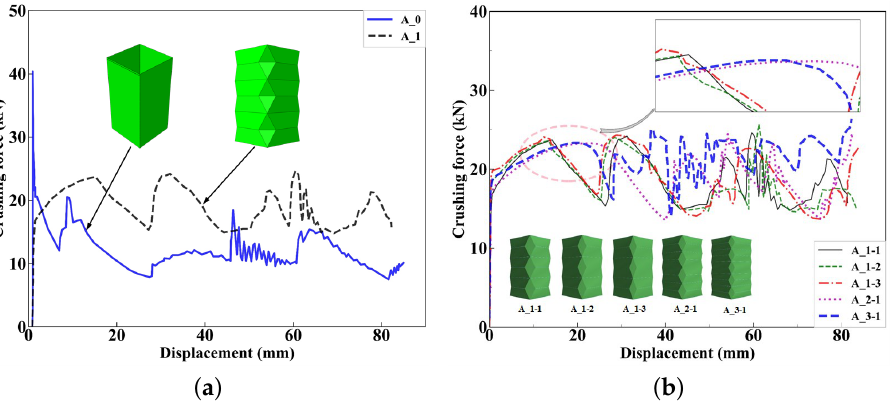
Figure 8. Crease pattern change and the crushing force versus displacement curves: ( a ) thin-walled square tube and origami tube; ( b ) crushing force versus displacement curves of the change in crease parameters